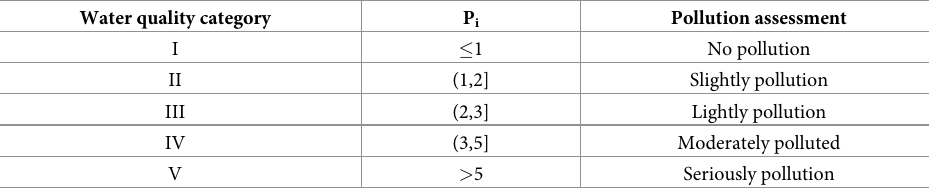
Table 1. Water quality category determination based on the single factor pollution index